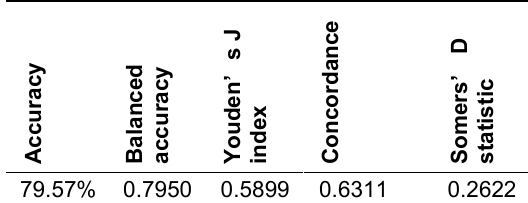
Table 2. Evaluation metrics of Adaptive boosting